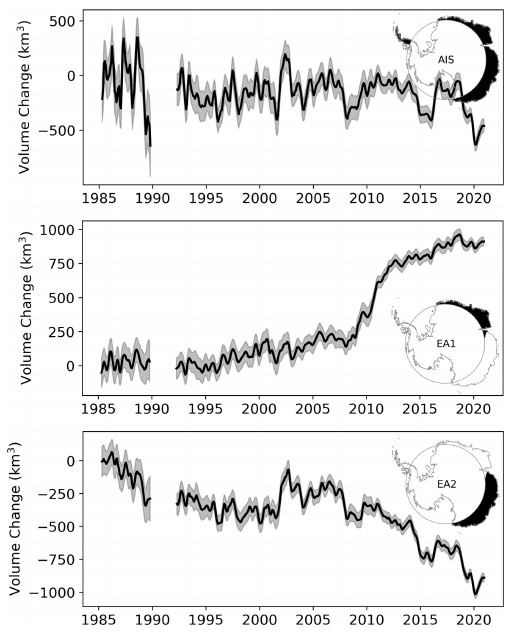
Figure 12. Monthly elevation change time series for the area mea- sured by Geosat (72 ◦ S latitude limit) for the period 1985–2020. The large difference in RMS seen in the Geosat time series for the full ice sheet is mostly driven by observations collected over the Antarc- tic Peninsula. The regional Geosat time series were recalibrated to allow for better alignment with the long-term record, as suggested in Sect. 6. This as the local offset estimated at each grid cell for Geosat might not be of sufficient quality